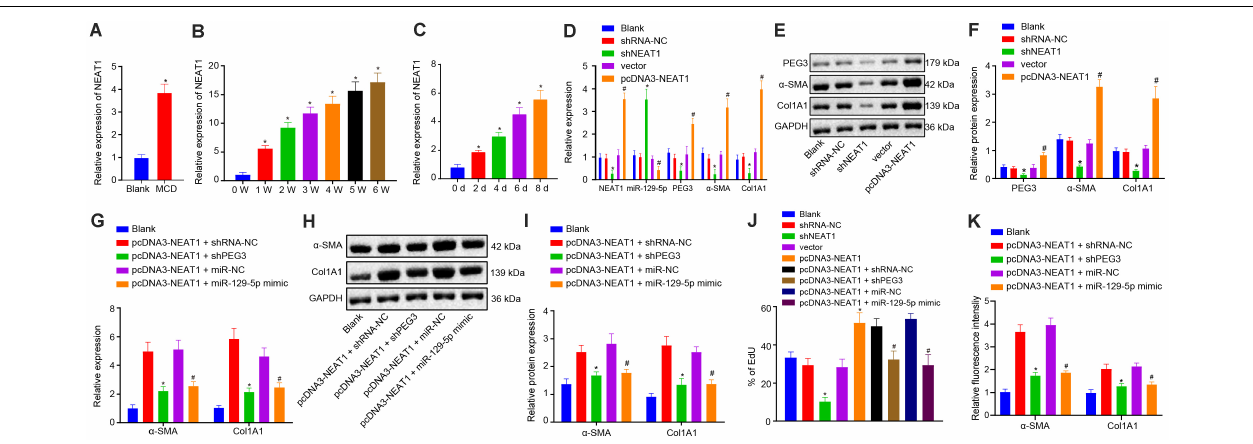
FIGURE 7 | NEAT1 leads to activation of HSCs via the miR-129-5p/PEG3 axis. (A) Relative expression of NEAT1 in liver tissue of mice at 5 weeks post-modeling. (B) Relative expression of NEAT1 in HSCs of mice on MCD diet from weeks 0 to 6; ∗ p < 0.05 vs. mice at 0 week. (C) Relative expression of NEAT1 in primary HSCs of mice on normal diet from days 0 to 8; ∗ p < 0.05 vs. mice on day 0. (D) Relative expression of NEAT1, miR-129-5p, PEG3, α -SMA, and Col1A1 determined by RT-qPCR. (E) Protein bands of PEG3, α -SMA, Col1A1, and GAPDH. (F) Relative protein levels of PEG3, α -SMA, and Col1A1 normalized to GAPDH determined by western blot analysis. In panels (D–F) , * p < 0.05 vs. the blank, shRNA-NC, or vector group (HSCs without any treatment or in the presence of shRNA-NC or vector). (G) Relative expression of α -SMA and Col1A1 in the presence of pcDNA3-NEAT1 determined by RT-qPCR. (H) Protein bands of α -SMA, Col1A1, and GAPDH in the presence of pcDNA3-NEAT1. (I) Relative expression of α -SMA and Col1A1 in the presence of pcDNA3-NEAT1 normalized to GAPDH determined by western blot analysis. In panels (G–I) , * p < 0.05 vs. the pcDNA3-NEAT1 + shRNA-NC group (HSCs in the presence of pcDNA3-NEAT1 + shRNA-NC); # p < 0.05 vs. the pcDNA3-NEAT1 + miR-NC group (HSCs in the presence of pcDNA3-NEAT1 + miR-NC). (J) HSC proliferation of mice on normal diet detected by EdU assay; * p < 0.05 vs. the shRNA-NC or vector group (HSCs in the presence of shRNA-NC or vector); # p < 0.05 vs. the pcDNA3-NEAT1 + shRNA-NC or pcDNA3-NEAT1 + miR-NC group (HSCs in the presence of pcDNA3-NEAT1 + shRNA-NC or pcDNA3-NEAT1 + miR-NC). (K) Quantitative analysis on α -SMA and Col1A1 immunofluorescence intensity in primary HSCs after transfection; * p < 0.05 vs. the blank (HSCs without treatment) or pcDNA3-NEAT1 + shRNA-NC group (HSCs in the presence of pcDNA3-NEAT1 + shRNA-NC); # p < 0.05 vs. the pcDNA3-NEAT1 + miR-NC group (HSCs in the presence of pcDNA3-NEAT1 + miR-NC). All data were measurement data and expressed as mean ± standard deviation. Comparison between two groups was analyzed using unpaired t -test. One-way analysis of variance was used for data comparison among multiple groups. The experiment was independently repeated three times. N = 6 mice per group.